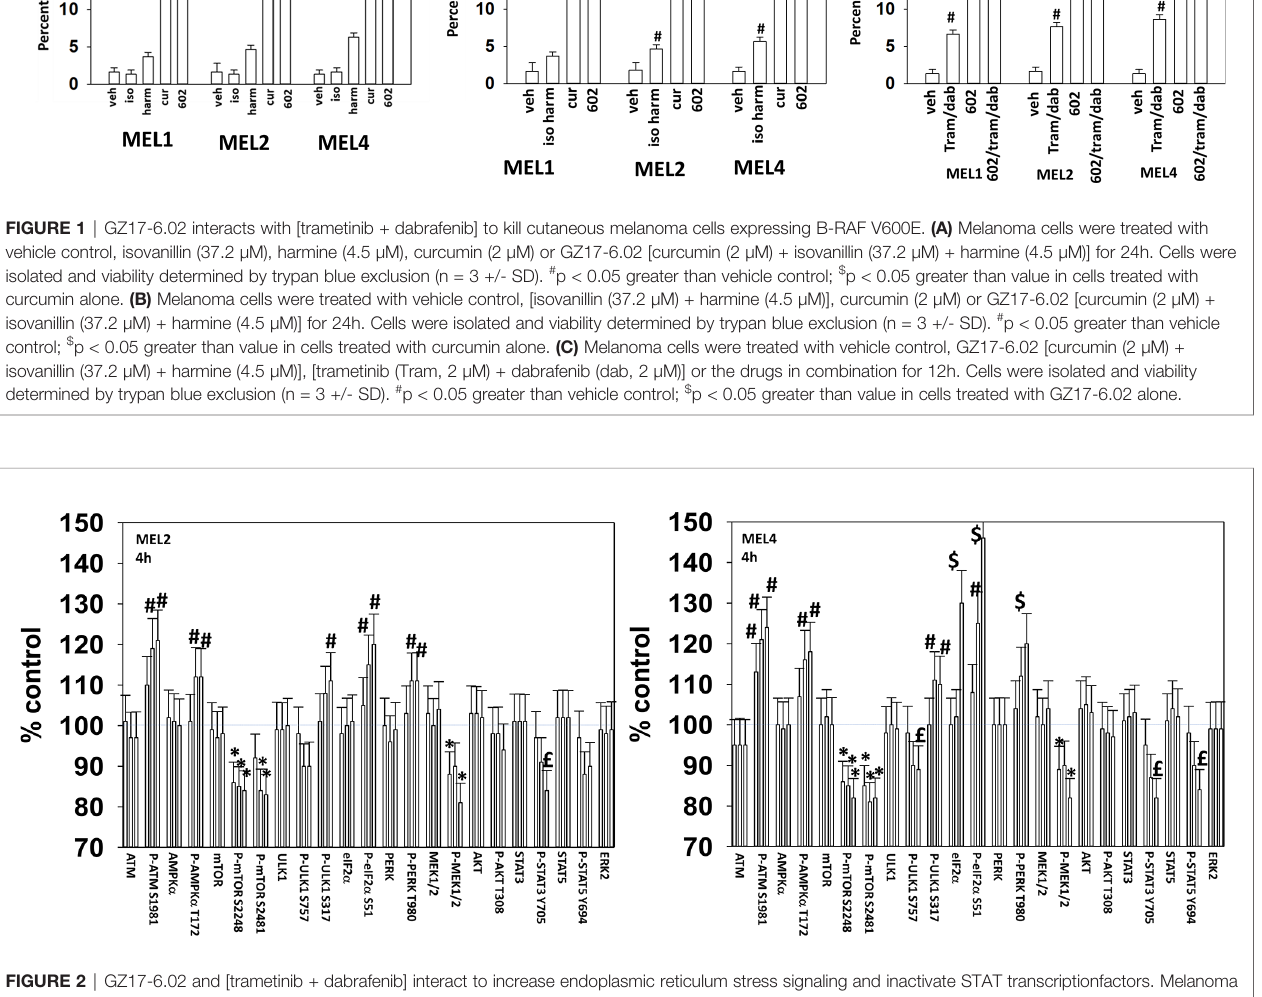
FIGURE 2 | GZ17-6.02 and [trametinib + dabrafenib] interact to increase endoplasmic reticulum stress signaling and inactivate STAT transcriptionfactors. Melanoma cells were treated with vehicle control, GZ17-6.02 [curcumin (2 µM) + isovanillin (37.2 µM) + harmine (4.5 µM)], [trametinib (2 µM) + dabrafenib (2 µM)] or the drugs in combination for 4h (the three bars per protein from left to right are trametinib/dabrafenib, GZ17-6.02 and the drugs combined). Cells were fi xed in place and in-cell immunostaining performed to determine the expression and the phosphorylation of the indicated proteins (n = 3 +/-SD) *p < 0.05 less than vehicle control; £ p < 0.05 less than either drug as a single agent; # p < 0.05 greater than vehicle control; $ p < 0.05 greater than either drug as a single agent.